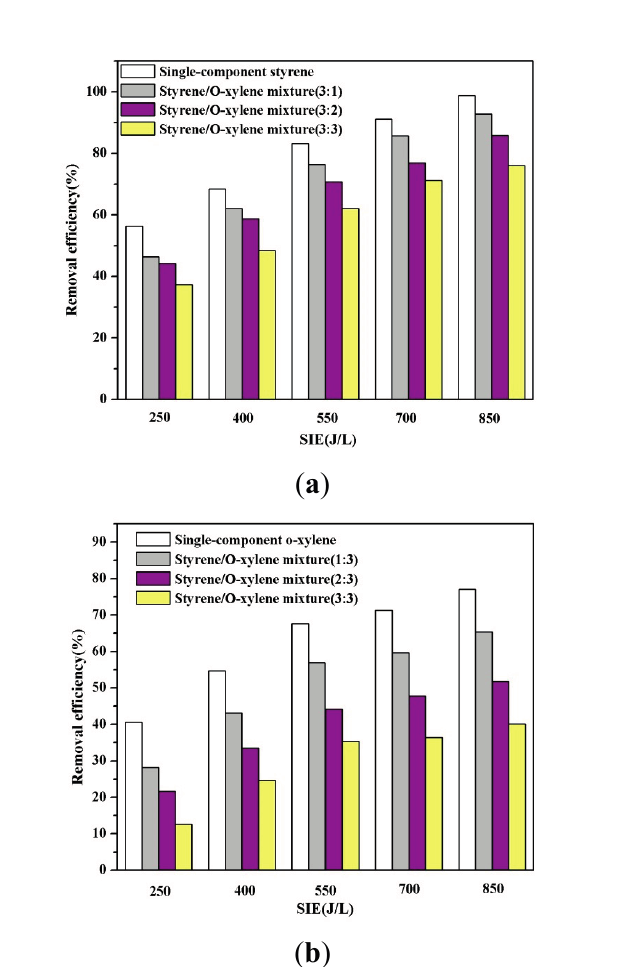
Figure 6. ( a ) Comparison of styrene removal efficiency for single-component and mixed VOCs; ( b ) Comparison of o -xylene removal efficiency for single-component and mixed